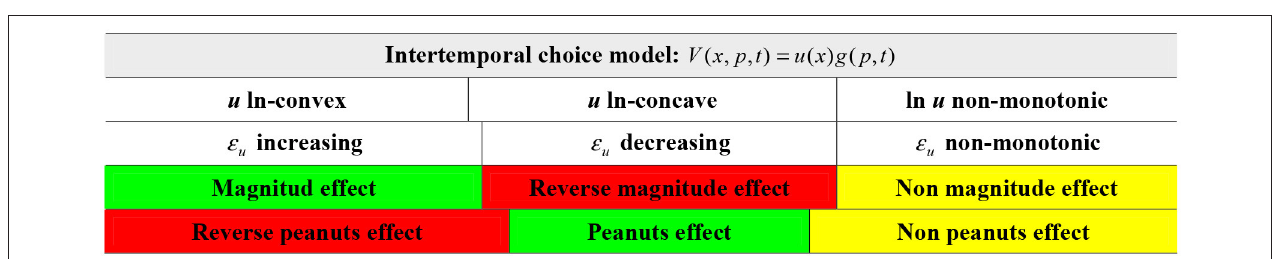
Frontiers in Applied Mathematics and Statistics |